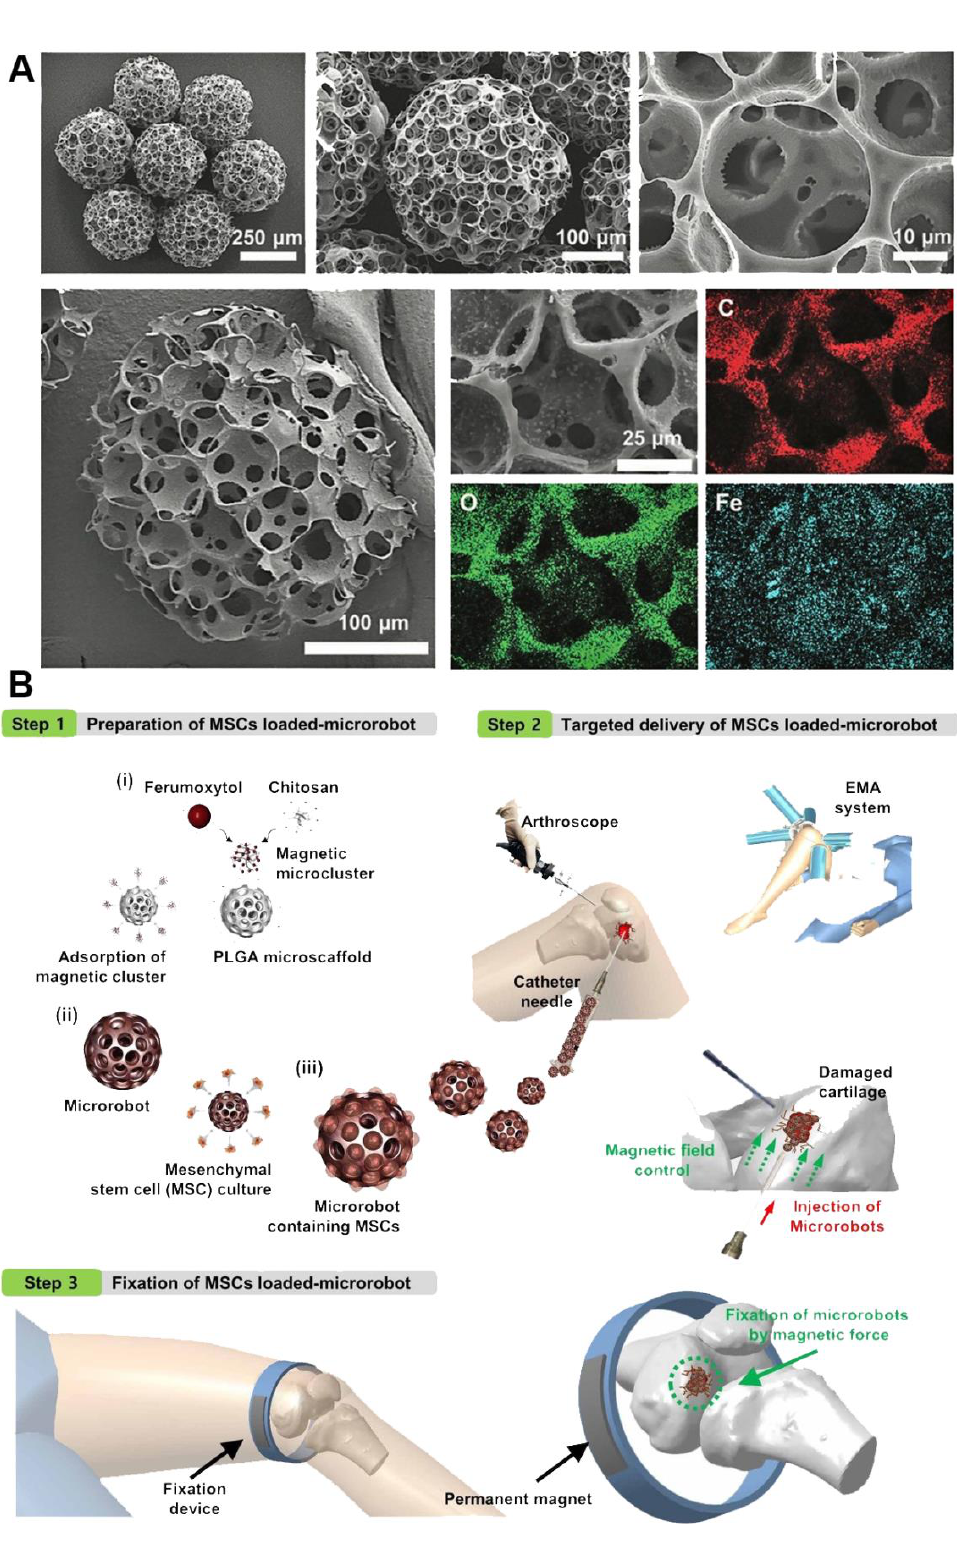
Figure 4. ( A ) Magnetic mini-scaffold for cell delivery fabricated using sacrificial materials. ( B ) Concept overview of knee cartilage regeneration procedures using a magnetic microrobot-mediated mesenchymal stem cell delivery system (From [16]. Reprinted with permission from AAAS).